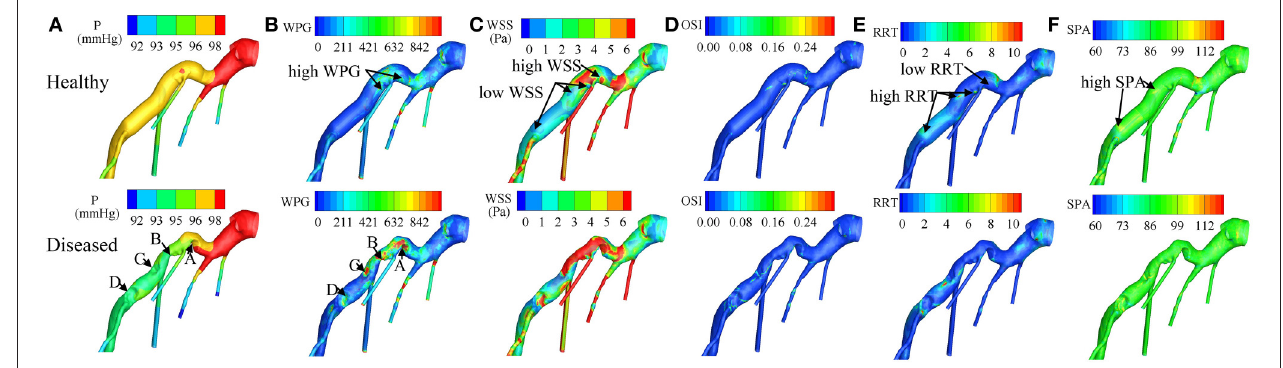
FIGURE 2 | Distributions of (A) P (Pressure), (B) WPG (wall pressure gradient), (C) WSS (wall shear stress), (D) OSI (oscillatory shear index), (E) RRT (relative residence time), and (F) SPA (stress phase angle) on the virtually healthy and diseased left coronary artery trees respectively. Labels of (A–D) indicate the stenosis locations. In the virtually healthy artery model, low WSS, and high RRT was exhibited in three of the four locations, where the stenoses were formed, and high WSS with low RRT was exhibited in the fourth. These findings suggest that coronary plaque is more likely to form in locations with low- WSS- and- high- RRT or high- WSS- and- low- RRT. From Zhang et al.